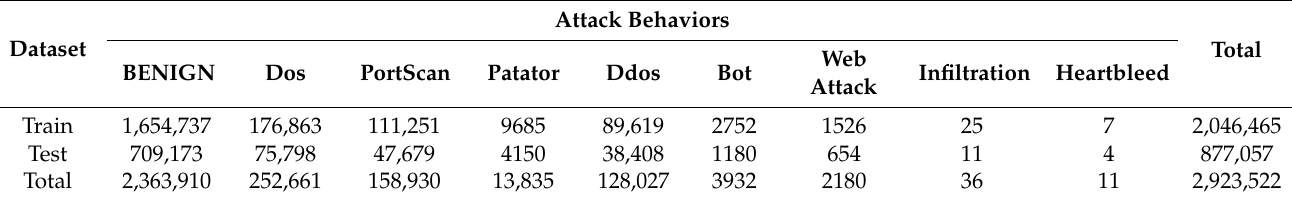
Table 5. Distribution of different attack behaviors in the CIC-IDS2017 dataset.